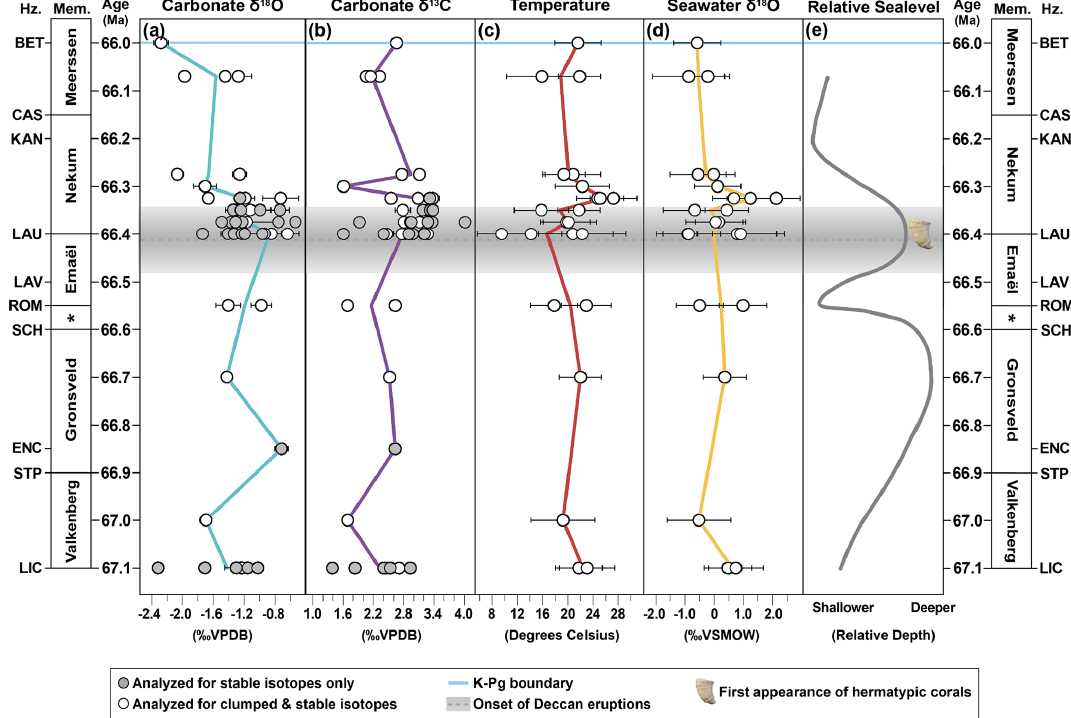
Figure 6. Isotopic compositions and paleotemperatures of fossil shells compared to inferred relative sea level in the Maastricht Formation. Error bars represent 1SD for δ 18 O (a) and δ 13 C (b) and represent external 1SE for temperature (c) and δ 18 O sw ( d ) (see Sect. 3.3). All samples failing diagenetic screening criteria have been removed. Colored lines pass through horizon means. Age model from Vellekoop et al. (2022; Table S3). The relative sea level curve (e) is based on Schiøler et al. (1997), adjusted to the age model used in this study. Hermatypic coral appearance data (e) are from Leloux (1999). Onset of the main Deccan Traps eruptions (grey dotted line) at 66 . 413 ± 0 . 067Ma (Sprain et al., 2019).